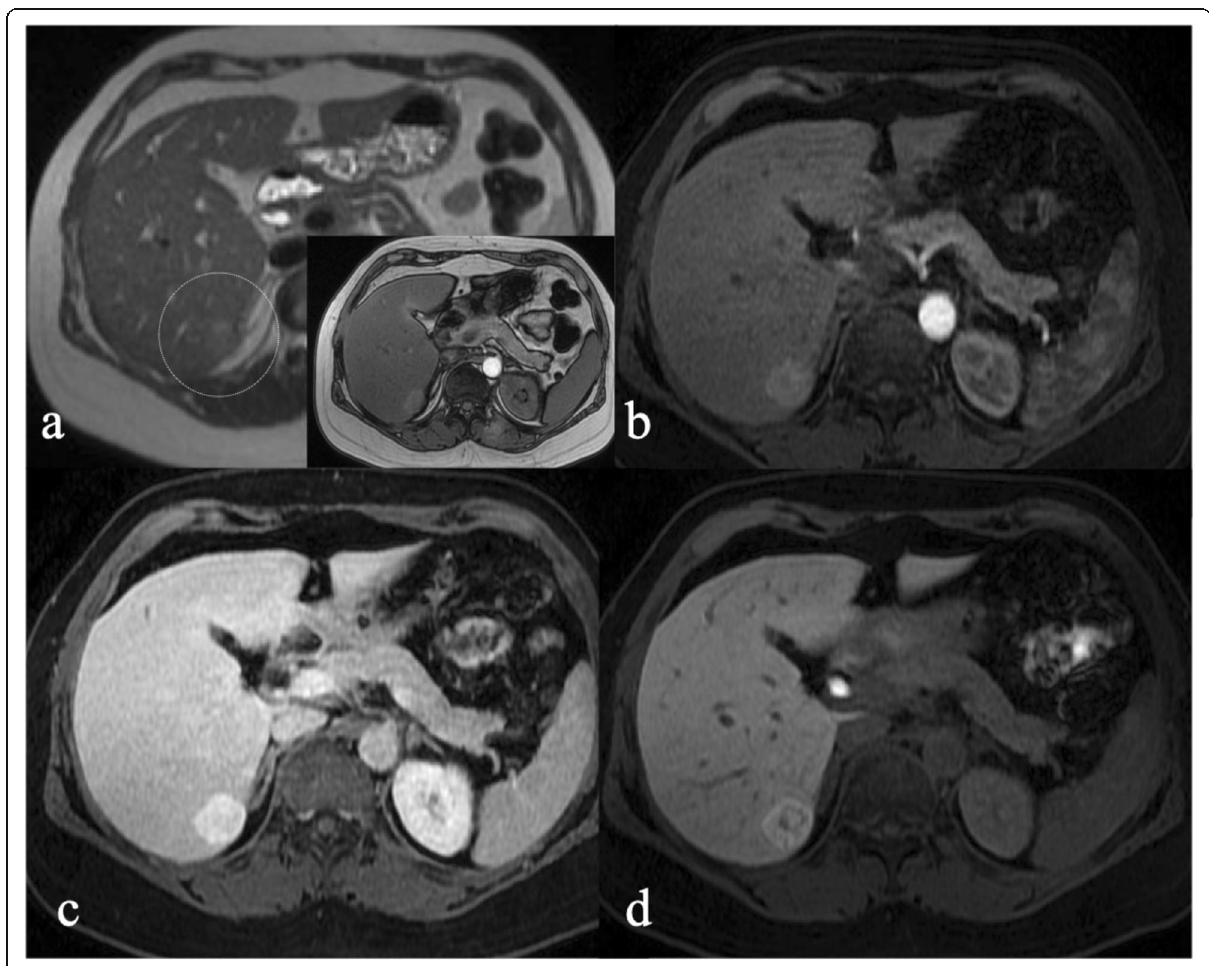
Fig 4. 46-year-old female with an incidentally detected liver lesion. Axial T2W ( a ) demonstrates a heterogeneous mildly T2 hyperintense lesion in segment VII (dotted circle in a ) with no internal fat on axial T1W opposed-phase (inset). Subtracted Gd-EOB-DTPA-enhanced axial T1W fat- saturated sequences demonstrate arterial enhancement ( b ), persistent high signal in the delayed phase ( c ) and retention of contrast in the HPB phase ( d ). R1 characterized this lesion as FNH before and after assessment of HPB phase. R2 initially classified this lesion as adenoma but reclassified as FNH after assessment of the HPB phase. Confidence in diagnosis decreased from high to moderate certainty for R2 and remained at high certainty for